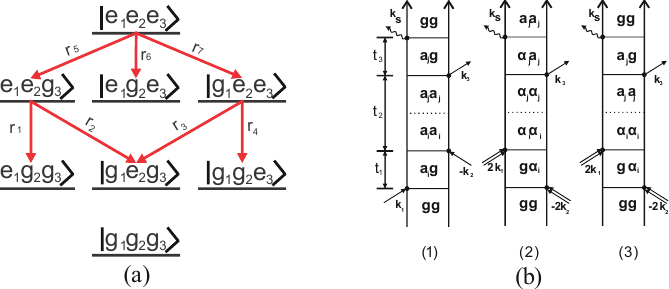
Fig.1. Site basis states of a molecular trimer. Arrows indicate unidirectional transfer to lower exciton manifolds due to EEA, with rates {𝑟 𝑖 } = {𝑟 1 , 𝑟 2 , 𝑟 3 , 𝑟 4 ,𝑟 5 = 𝑟 3 , 𝑟 6 = 𝑟 1 + 𝑟 4 , 𝑟 7 = 𝑟 2 } . (b) Examples for double sided Feynman diagrams contributing to a 3 rd (1) and 5 th (2, 3) order signal. |𝐺⟩ ∶= |𝑔 1 𝑔 2 𝑔 3 ⟩ is the ground state wave function, {|𝑎 𝑖 ⟩} and {|𝛼 𝑖 ⟩} are the eigenstates of the Frenkel exciton Hamiltonian of the 1 st and 2 nd exciton manifold, respectively. Pathways (1) and (2) represent transport inside excitonic